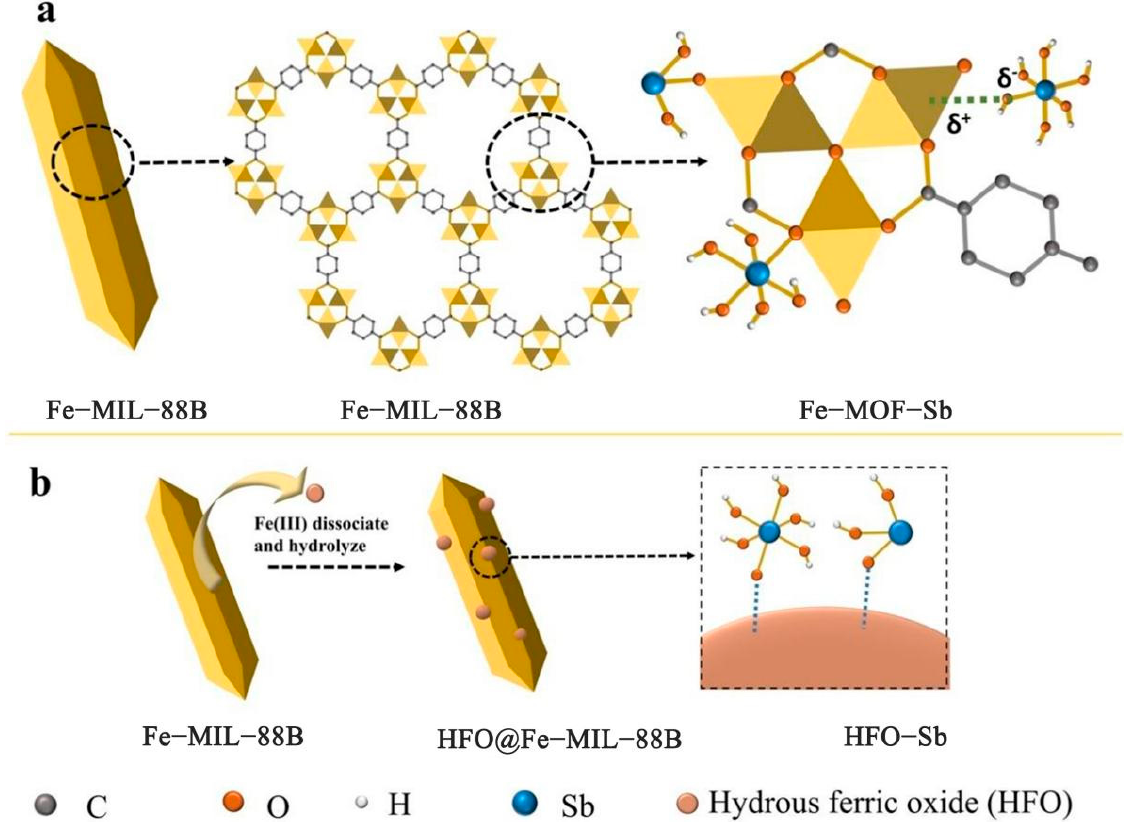
Figure 4. ( a ) Complexes Fe − O − Sb formed by incompletely coordinated Fe ions with Sb(III)/(V), ( b ) In situ formation of HFO (hydrated iron oxide) provides additional active sites for adsorption [140].